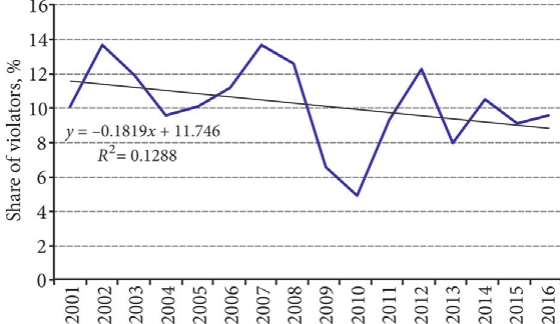
Fig. 6. Compliance of pedestrians with traffic lights in Estonia